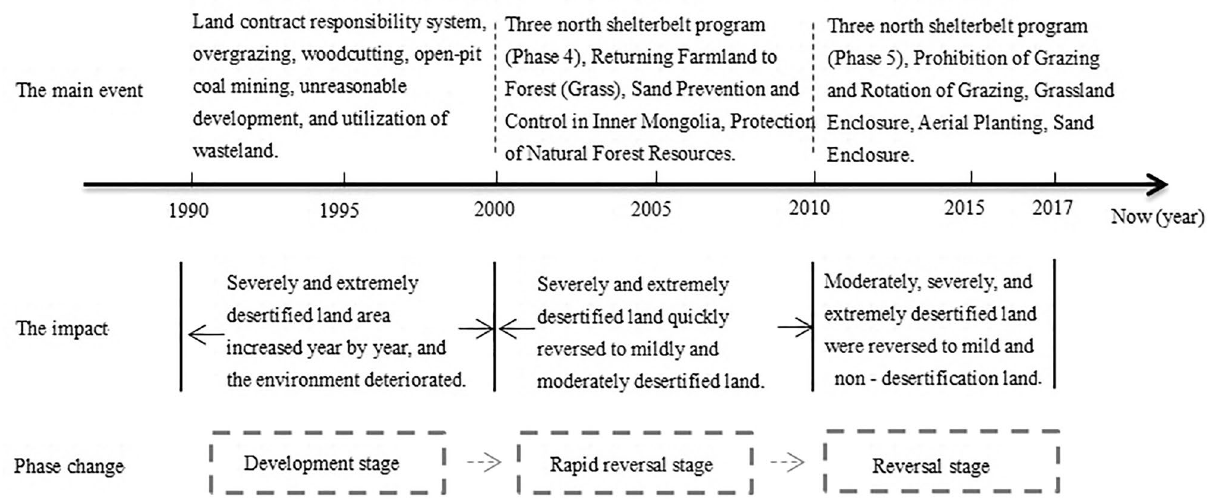
Figure 9. Timeline of human activities in the Mu Us Sandy Land from 1990 to